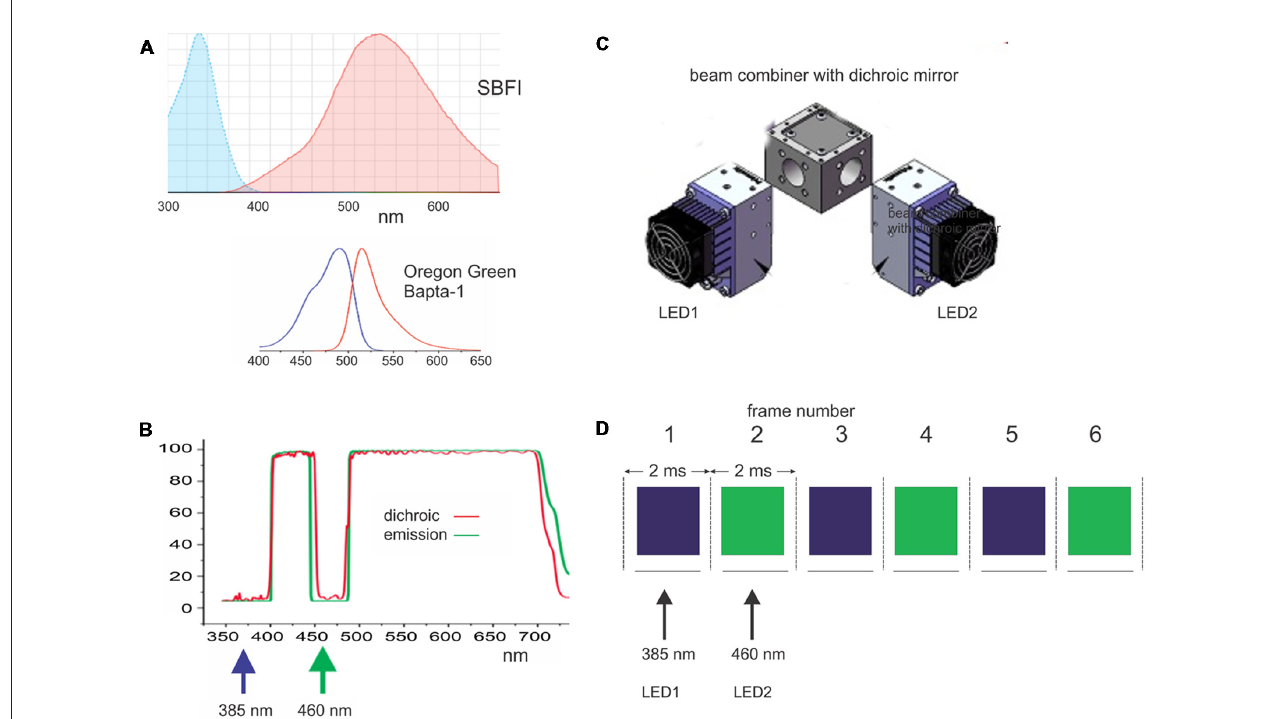
FIGURE 1 | Components of the apparatus used to make simultaneous sodium and calcium measurements with light emitting diode (LED) excitation sources. (A) Excitation and emission spectra of SBFI (sodium indicator) and Oregon Green Bapta-1 (OGB-1; calcium indicator). Both sets of spectra are plotted on the same wavelength scale to show the separation of the excitation bands. (B) Custom dichroic and emission filters used for these two indicators. Note the notch in the filters to pass 460 nm excitation light for OGB-1. (C) Two LEDs (385 nm and 460 nm) together with a beam combiner with a dichroic mirror (DM) used to excite the two indicators. (D) Pattern of excitation and detection: every 2 ms alternate 1.8 ms LED pulses excite the indicators. The switching is synchronized to the frames of the CCD camera operating at 500 Hz. Adapted from Miyazaki and Ross (2015).